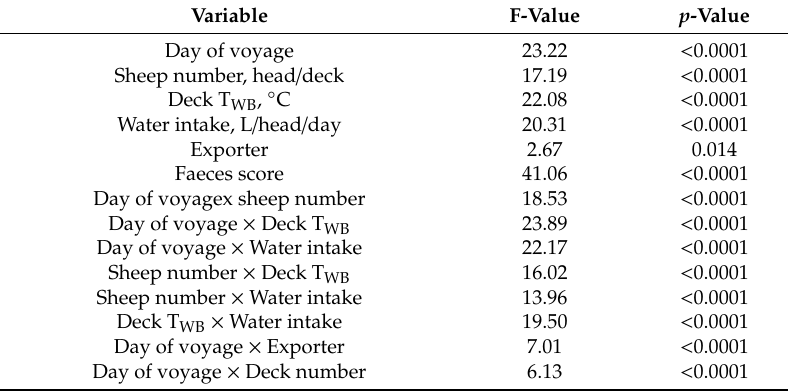
Table 3. Significant ( p < 0.05) variables related to sheep mortality rate (%/deck/day) in a general linear model with R 2 (adj) = 85.14%. Table 4. Significant ( p < 0.05) variables related to sheep mortality rate (% / deck / day) in a general linear model with R 2 (adj) = 85.14%.